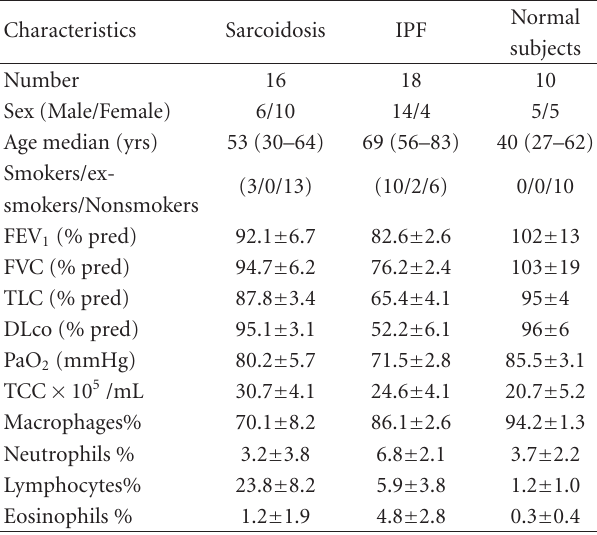
Table 1: Demographic and lung function characteristics of patients with IPF and Pulmonary Sarcoidosis. Values are expressed as mean + SD, and age as median